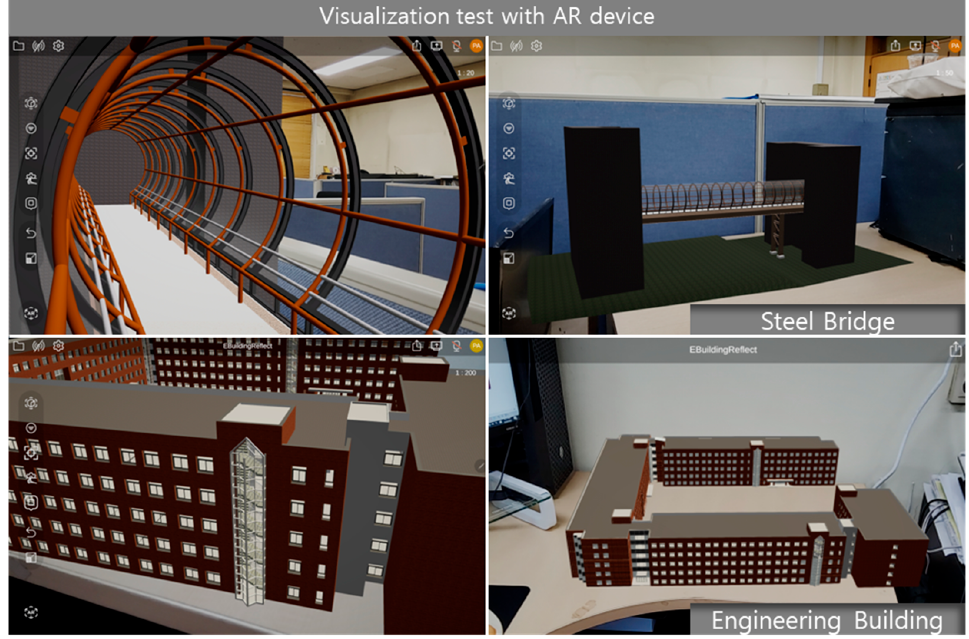
Figure 11. Optimized model visualization with AR device.